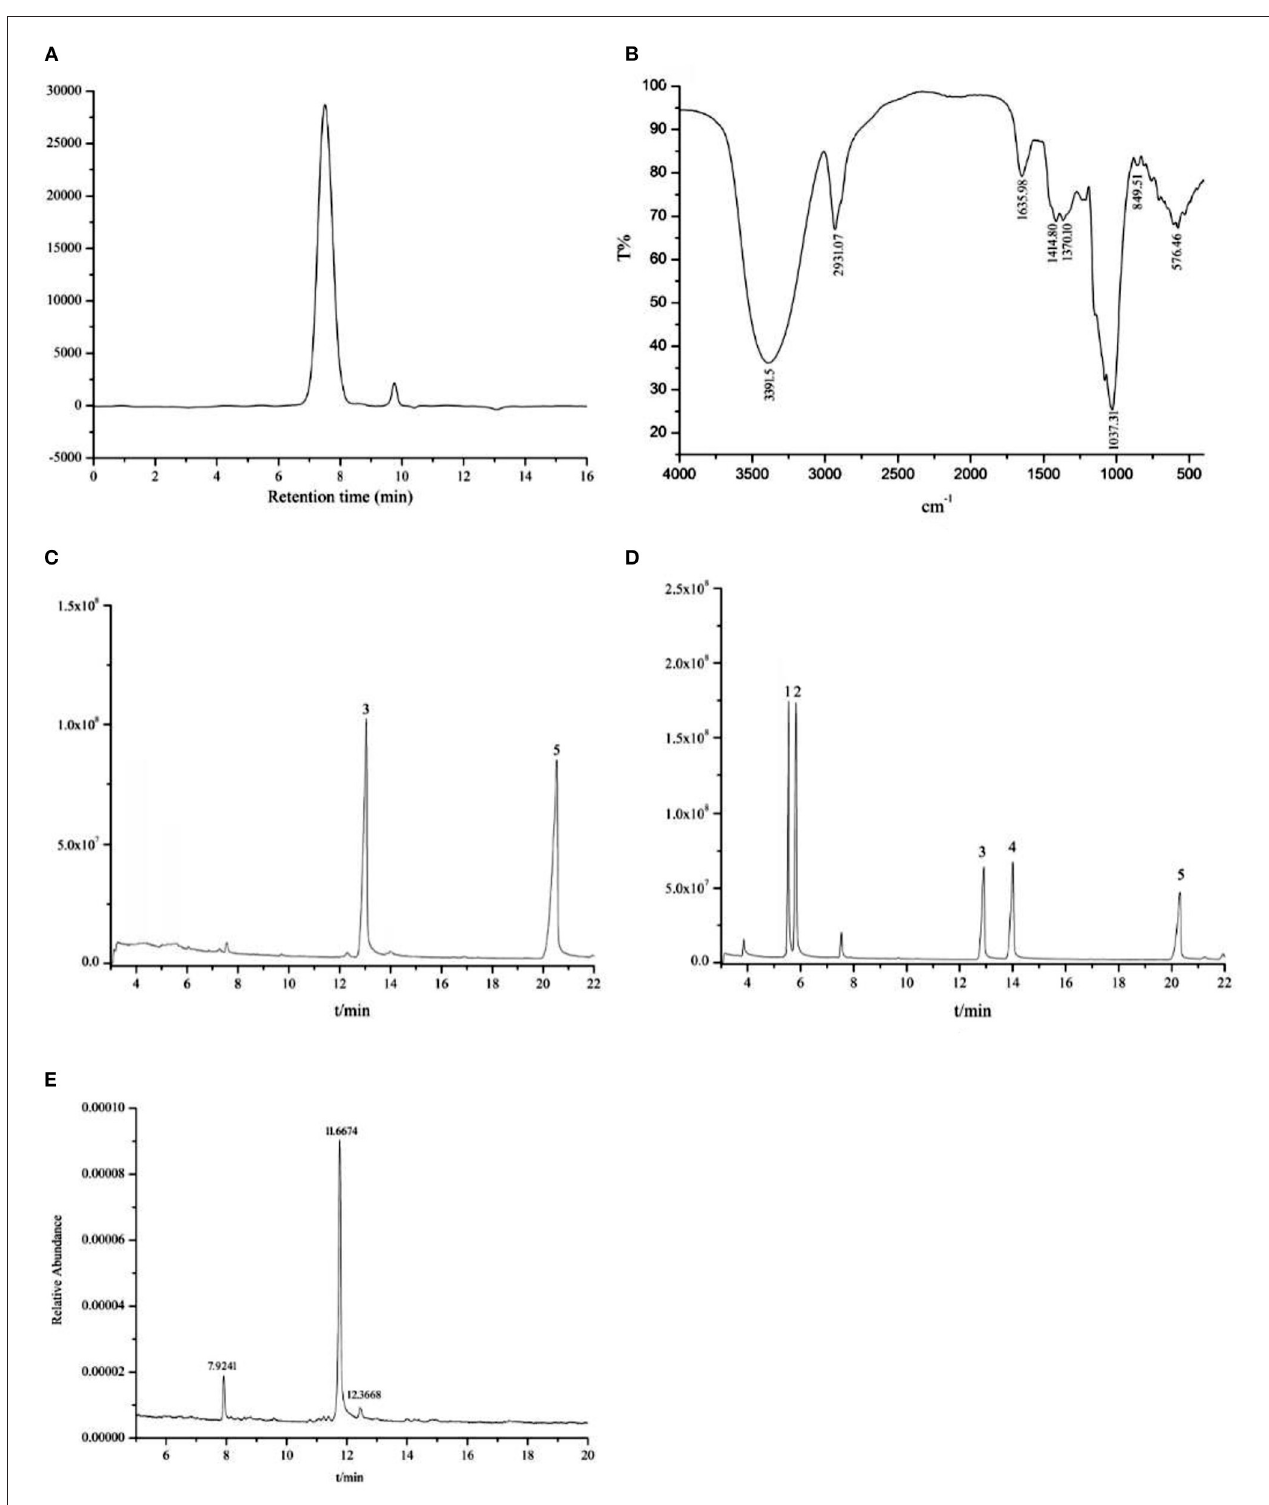
FIGURE 1 | The physicochemical properties and structure characterization of MDP. (A) HPGPC chromatogram of MDP; (B) FT-IR of MDP. (C) GC-MS study of the monosaccharide composition of MDP; (D) GC-MS analysis of mixed standards. (1) Ara; (2) Xyl; (3) Glc; (4) Gal; (5) internal standard; (E) GC-MS analysis of the MDP methylation